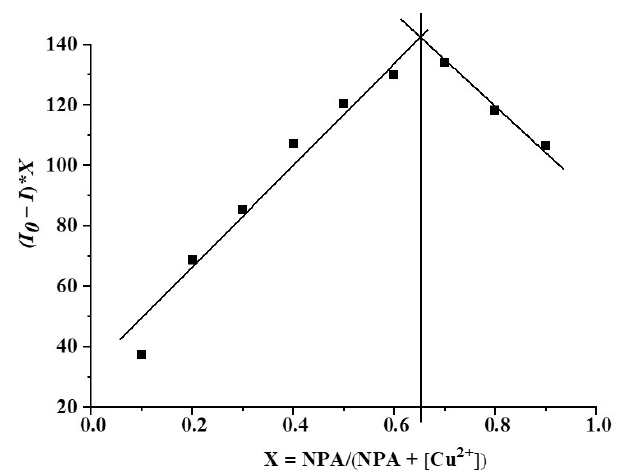
Figure 3. Job’s plot for the binding ratio between NPA and Cu 2+ .